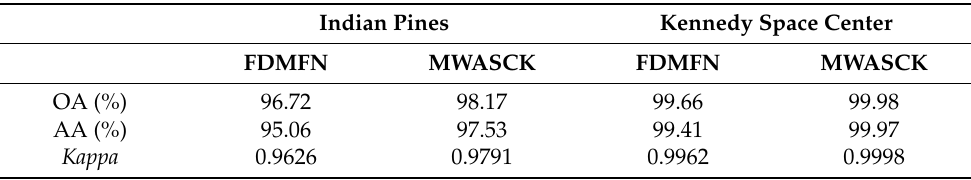
Table 5. Classification accuracy of the MWASCK and the FDMFN on Indian Pines and Kennedy Space Center datasets.